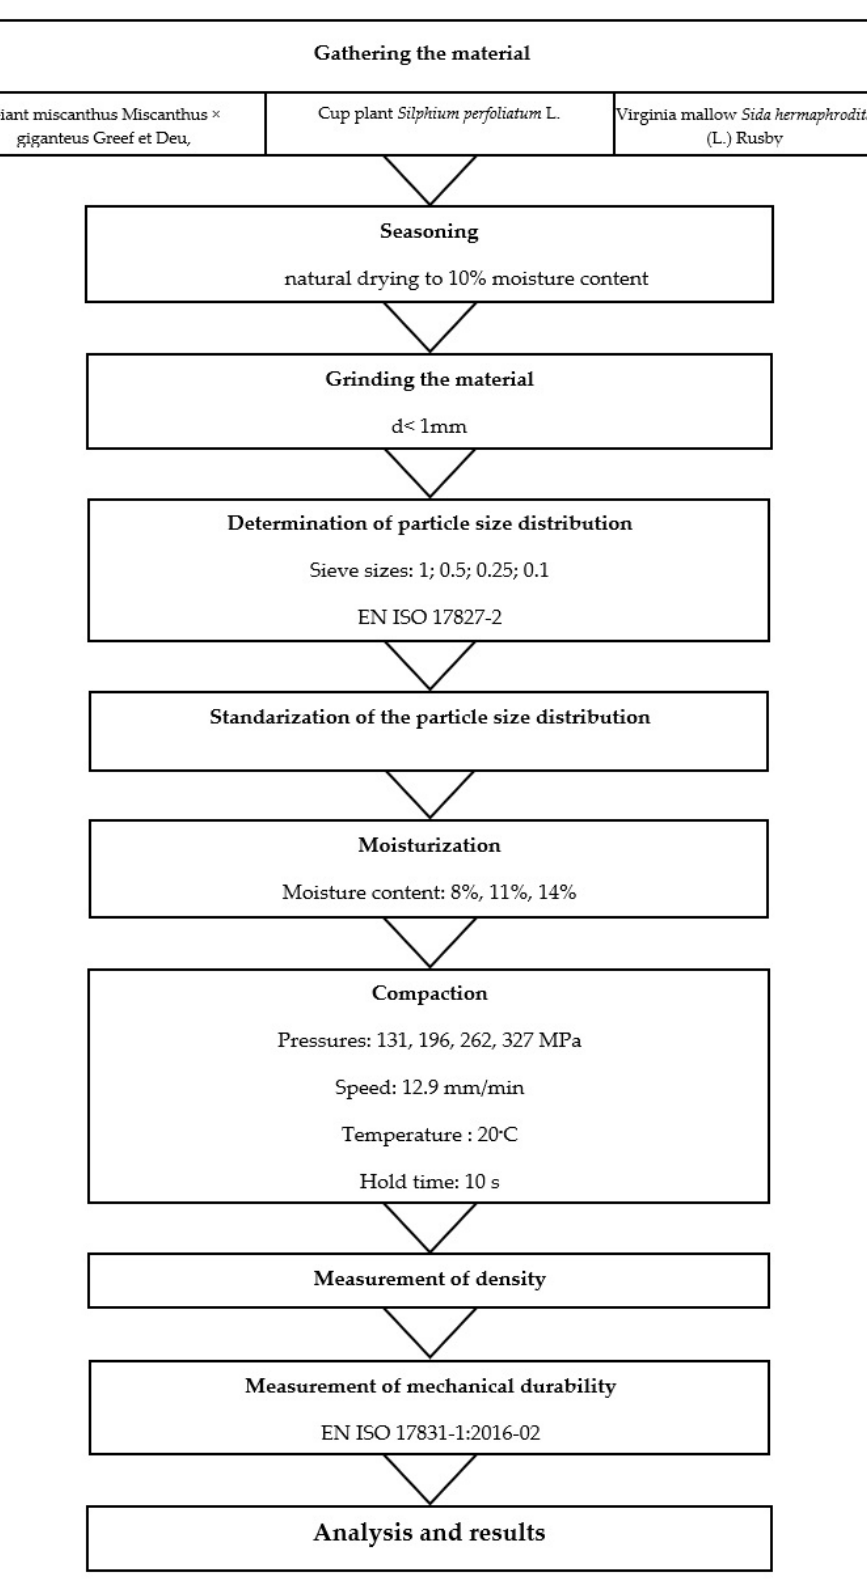
Figure 1. Research Figure 1. Research schedule.